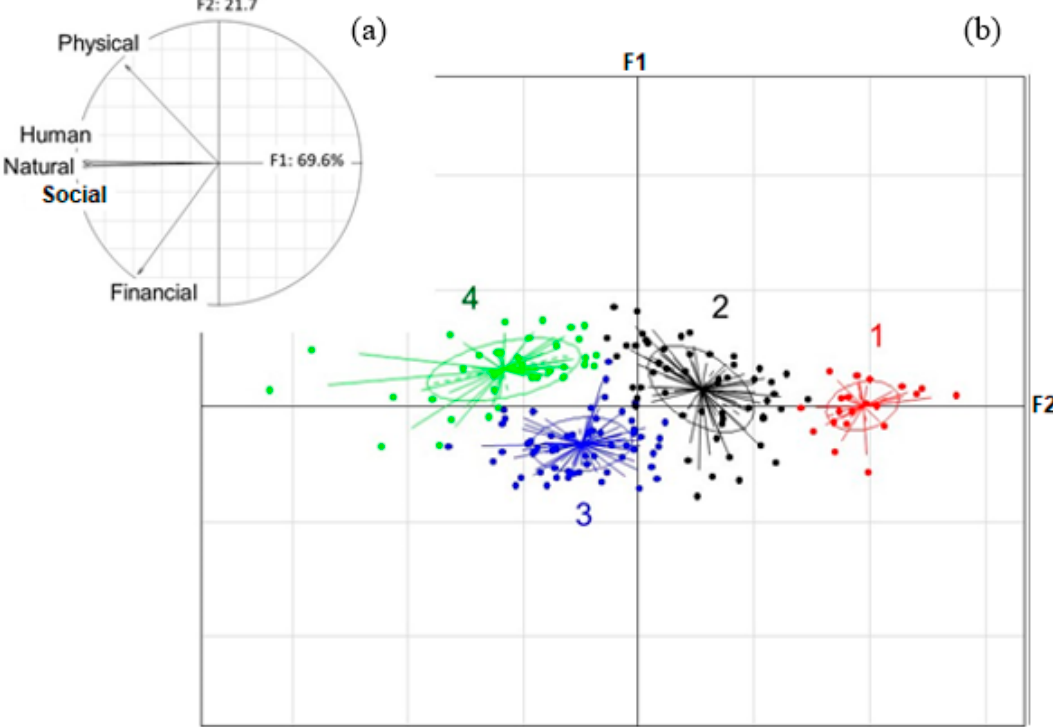
Figure 4. Projection of capital indices ( a ) and farms of the cattle ranching system distributed in four clusters ( b ) in the factorial plane F1F2 of a principal component analysis.